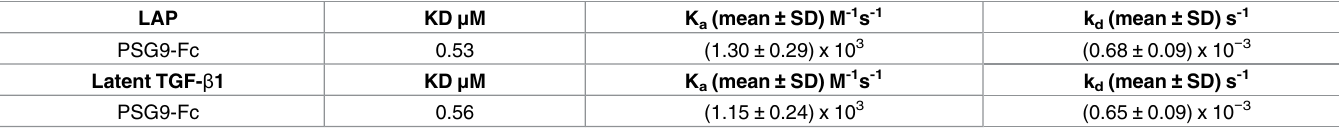
Table 1. Kinetic analysis of PSG9-Fc interaction with human SLC and LAP of TGF- β 1 . LAP KD μ M K a (mean ± SD) M -1 s -1 k d (mean ± SD) s -1 PSG9-Fc 0.53